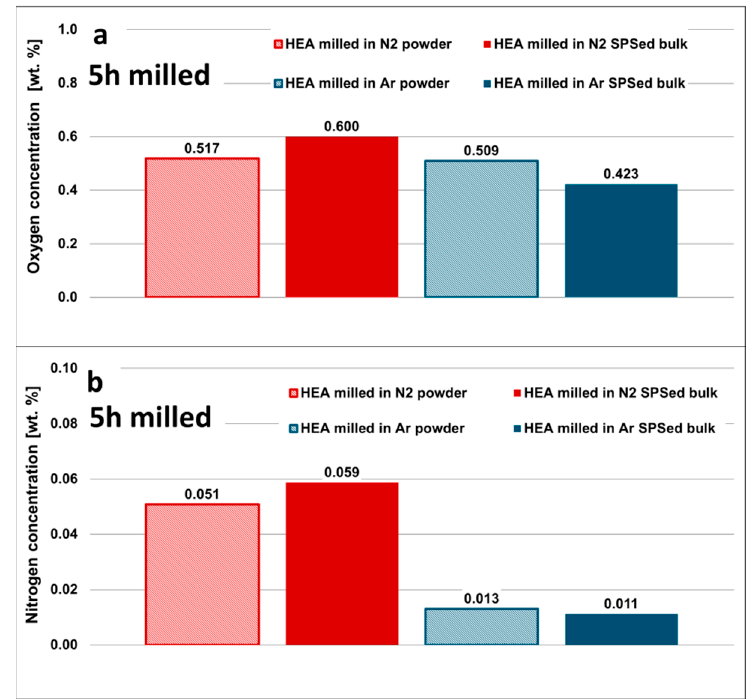
Figure 7. Comparison between the powder and bulk materials of HEA milled for 5 h in Ar and N 2 atmosphere; ( a ) oxygen concentration and ( b ) nitrogen concentration. The nitrogen and oxygen concentrations are retained after the SPS, within the scatter of the measurements and their accuracy.